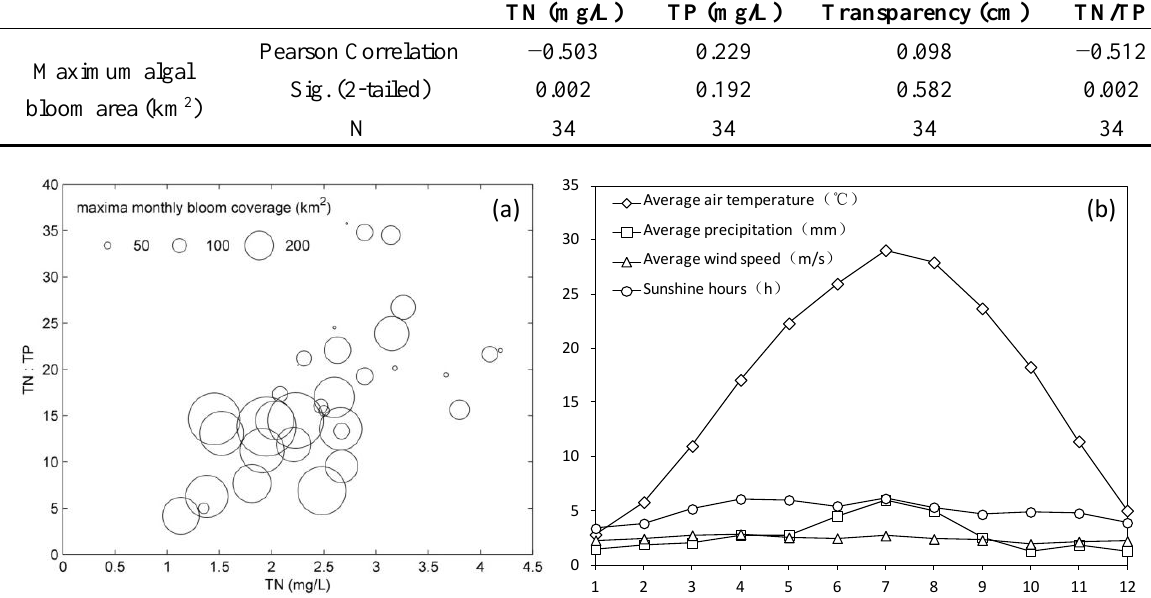
Figure 9. ( a ) Nutrient concentration (TN) and stoichiometry (TN to TP ration) with monthly maximum algal bloom coverage in Lake Chaohu during three different years (2008, 2012, and 2013). Bubble size is monthly maximum algal bloom area. ( b ) Monthly variations of temperature, wind speed, precipitation, and sunshine hours from 2000 to